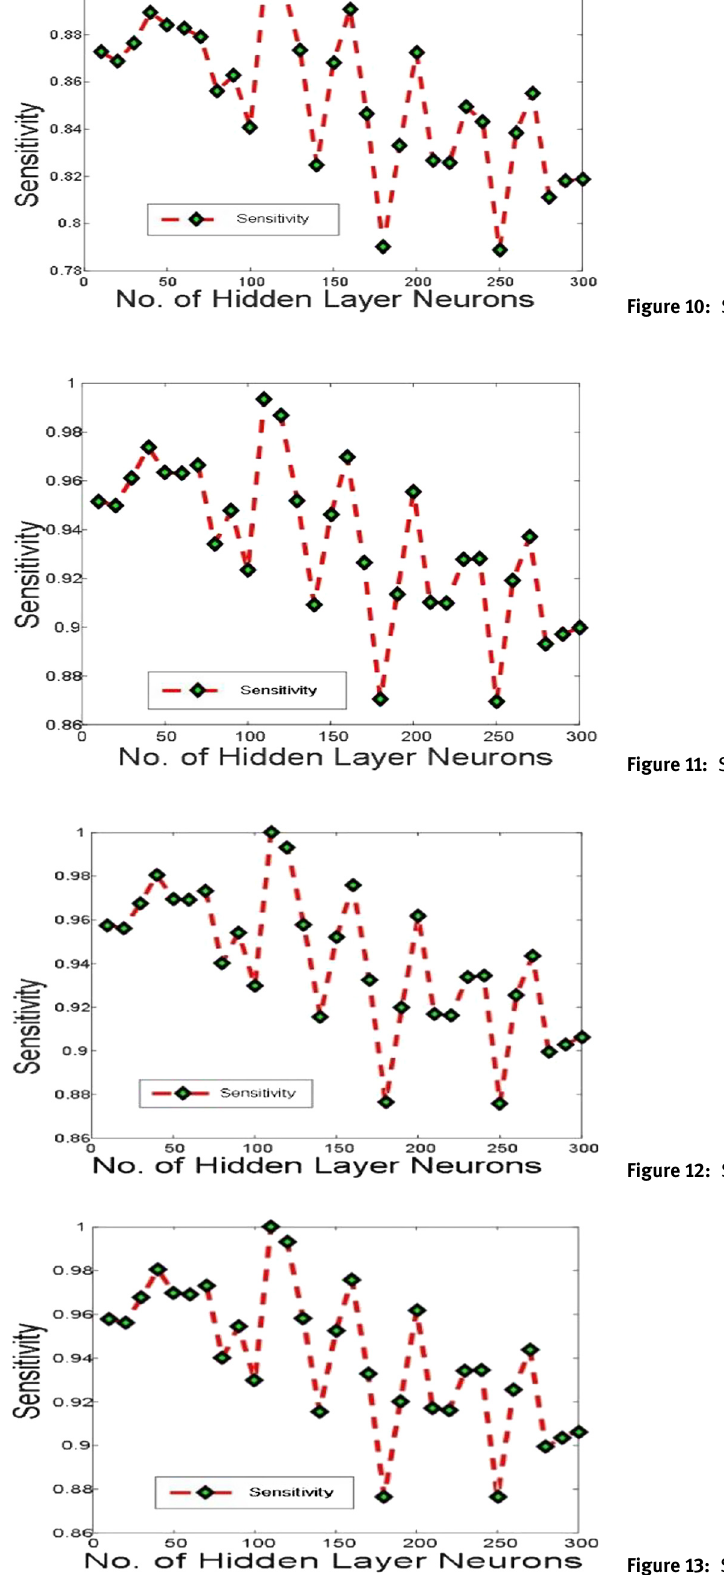
Figure 13: Sensitivity in CJaya-ELM.